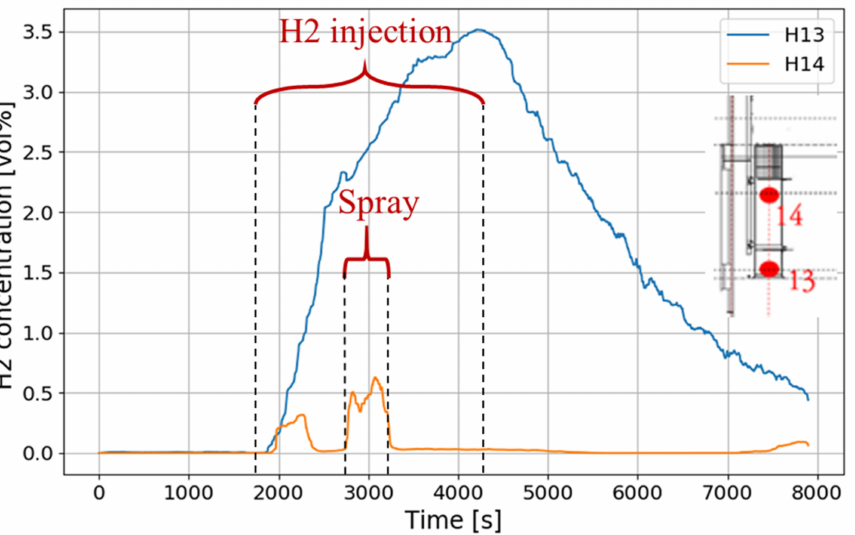
Figure 25. Time variations in the hydrogen concentrations at the PAR inlet and outlet during the SSP4 test. H13: PAR inlet; H14: PAR